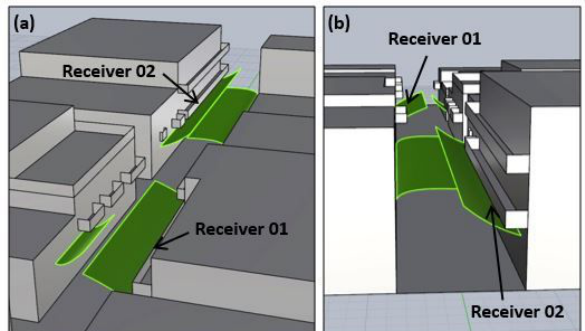
Figure 14: View of Tindari street with optimum parabolic profiles. (a) South-East view; (b) North